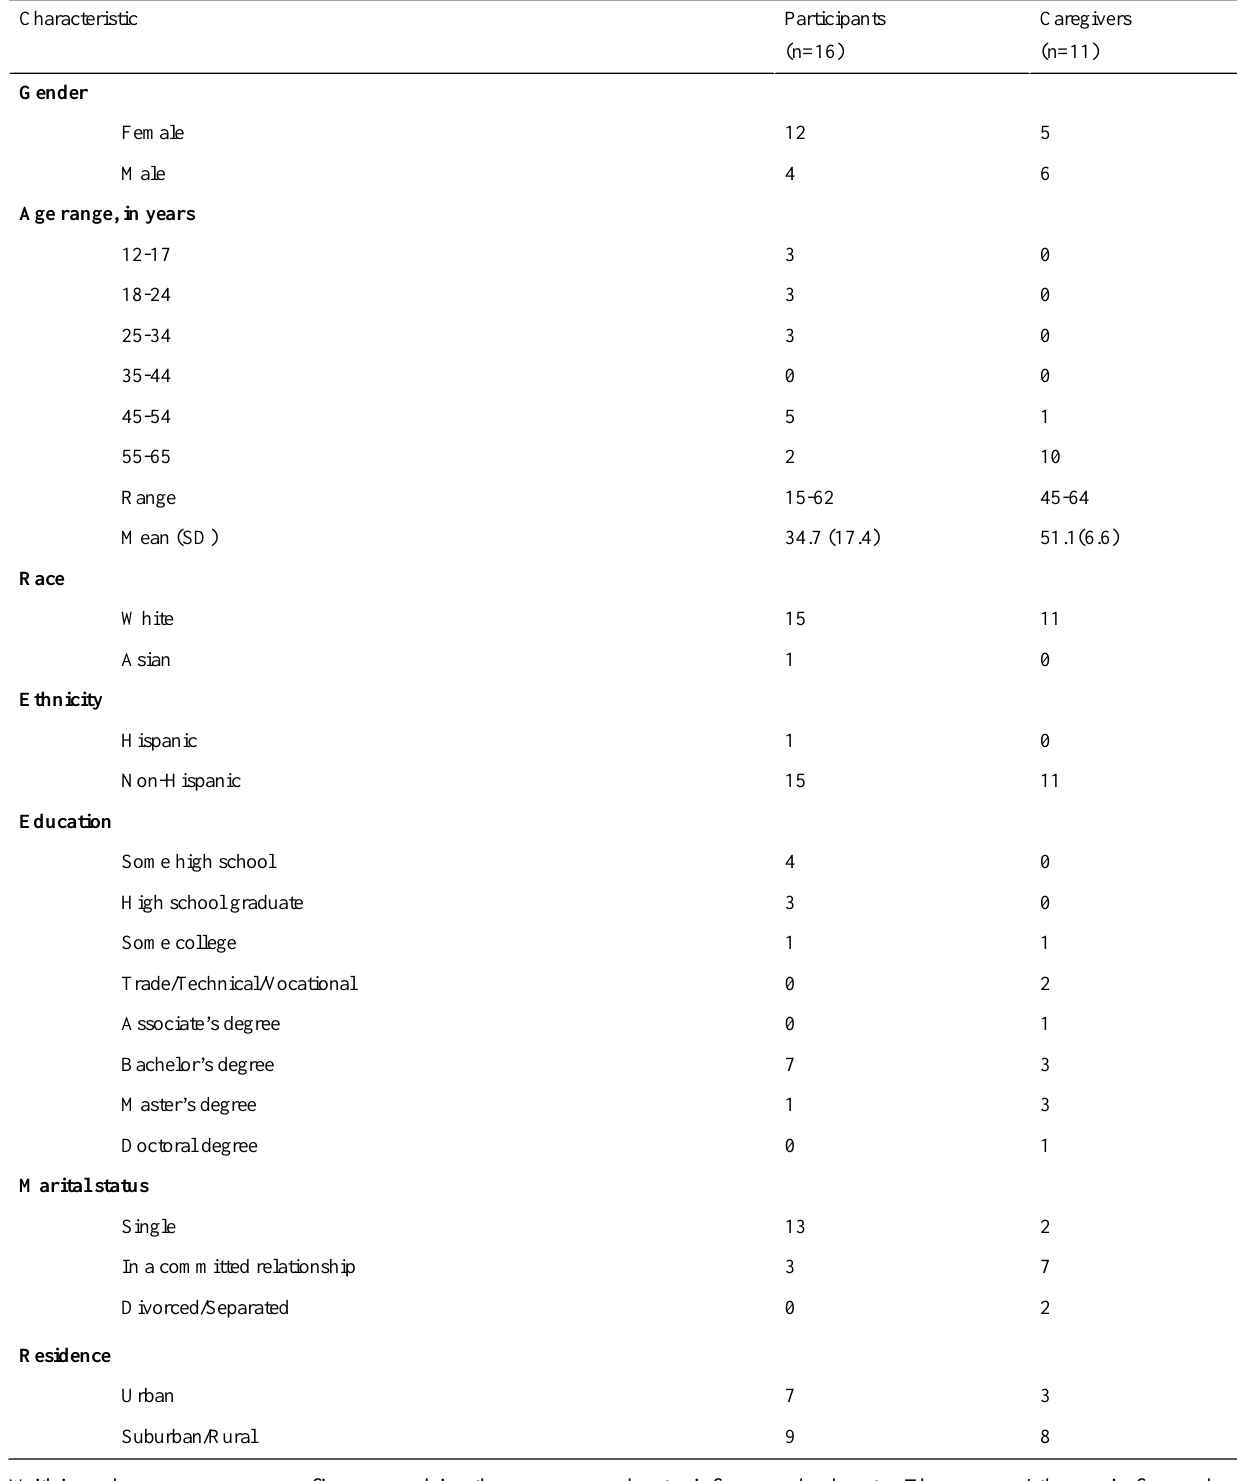
Table 1. Demographic characteristics of focus group